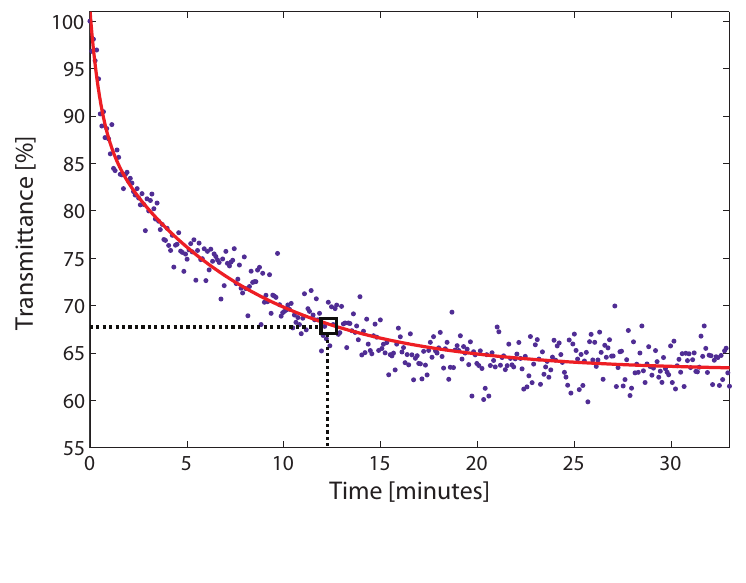
Figure 5. Normalized transmittance as a function of time measured at the center of the Q- branch, at 1331.55 nm. Dots represent the experimental data and solid red line, the double exponential fit. The filling time is